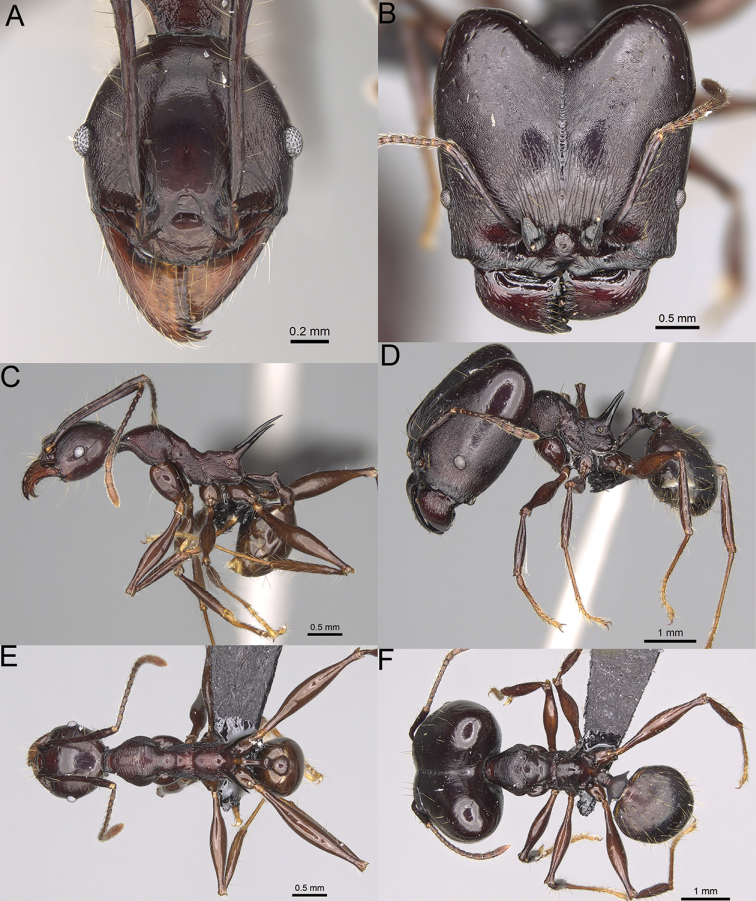
Pheidole
praegrandis sp. nov., full-face view (A), profile (C), and dorsal view (E) of paratype minor worker (CASENT0494945) and full-face view (B), profile (D), and dorsal view (F) of holotype major worker (CASENT0494942).